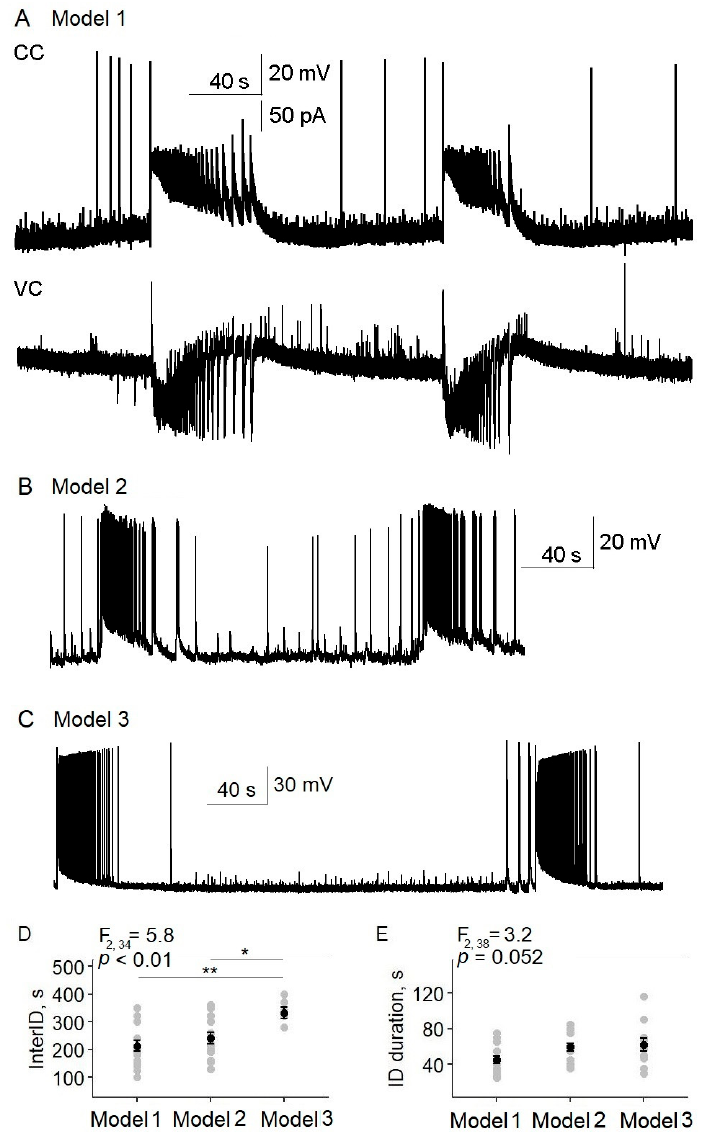
Figure A1. Stable ictal activity was observed in the entorhinal cortices of all three models: ( A ) Thy1-ChR2-YFP and ( B ) PV-Cre mice and ( C ) Wistar rats in 4-AP solution. ( D ) The intervals between ictal discharges (InterID) were the same for mice but less than that for rats (one-way ANOVA with post hoc Tukey test). ( E ) The duration of the ictal discharges did not differ. The InterIDs were 213 ± 19 ( n = 17), 241 ± 20 ( n = 14), and 332 ± 20 s ( n = 6) for Models 1–3, respectively; ID durations were 45 ± 4 ( n = 15), 59 ± 5 ( n = 15), and 62 ± 7 s ( n = 11) for Models 1–3, respectively. * p < 0.05, ** p <